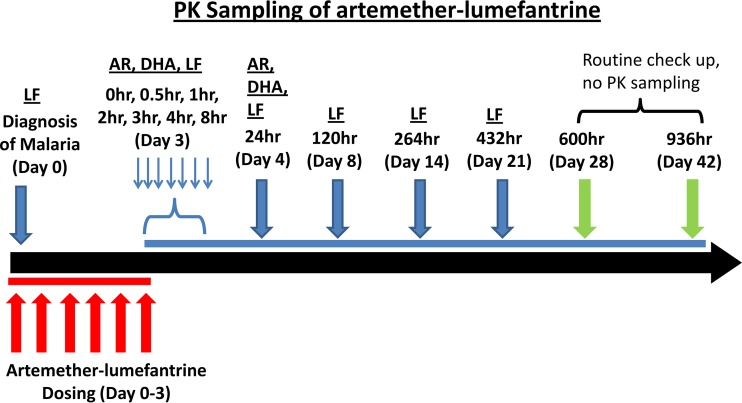
Blood for pharmacokinetic analyses was collected on study day 0 (prior to first dose) and before and 0.5, 1, 2, 3, 4, 24, 120, 264 h (day 14), and 432 (day 21) h after the last (6th dose). While the 120-h time point technically fell on day 8 in this study, the 120-h time is consistent with day 7 values previously reported in the literature, since in both cases, this time point is 120 h after the last AL dose. Thus, for our study, the 120-h/day 8 time point is referred to as day 7 throughout. AR, artemether; LF, lumefantrine.